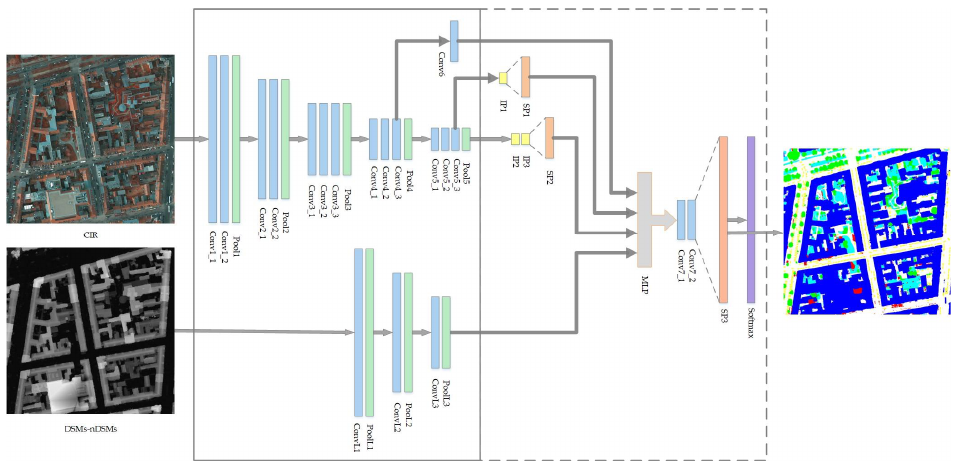
Figure 3. Network architecture of FSN, where structure depicted in the solid-line box is encoder and structure depicted in the dashed-line box is decoder.